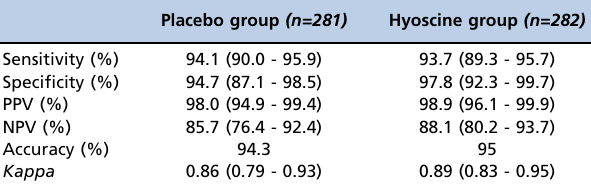
Table 2 - Diagnostic criteria of the lesions using digital